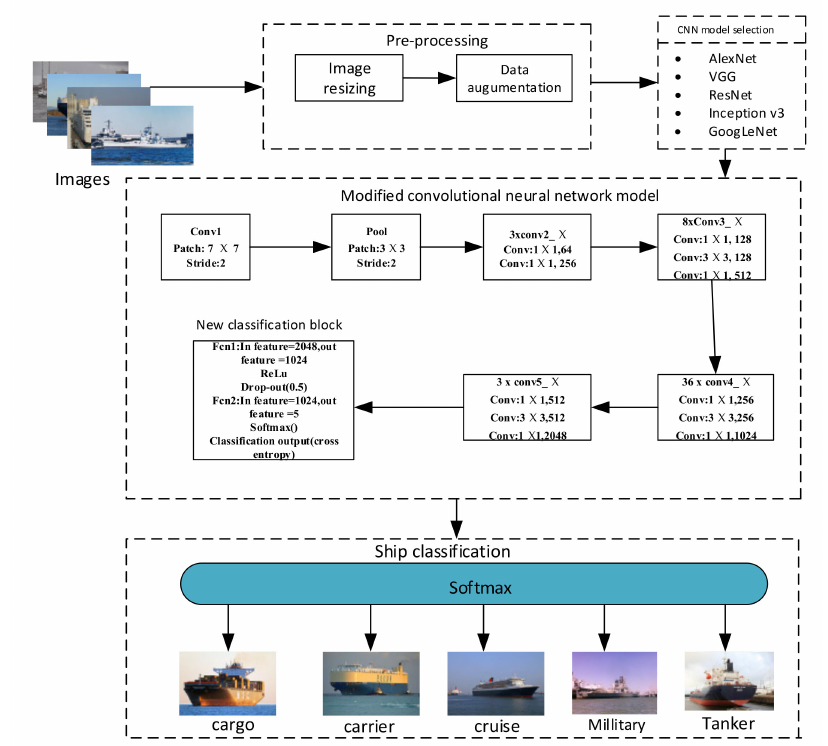
Figure 5. Proposed architecture of modified Resnet